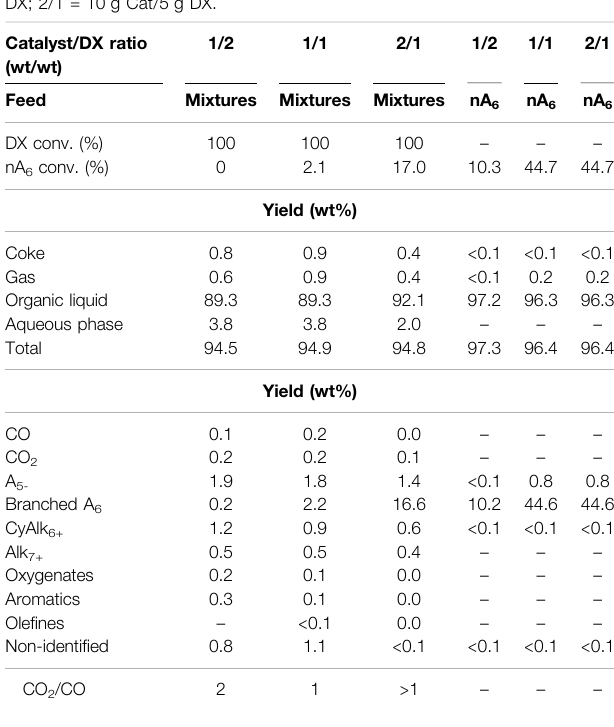
Frontiers in Chemistry |